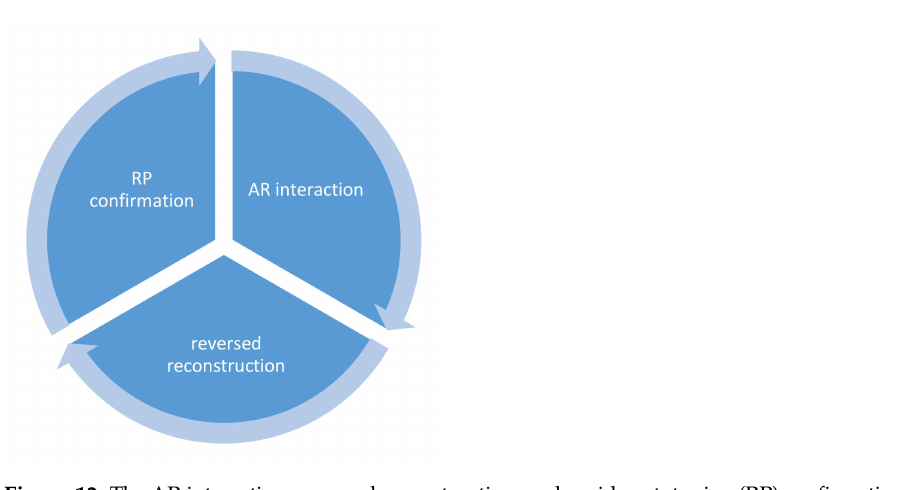
Figure 12. The AR interaction, reversed reconstruction, and rapid prototyping (RP) confirmation